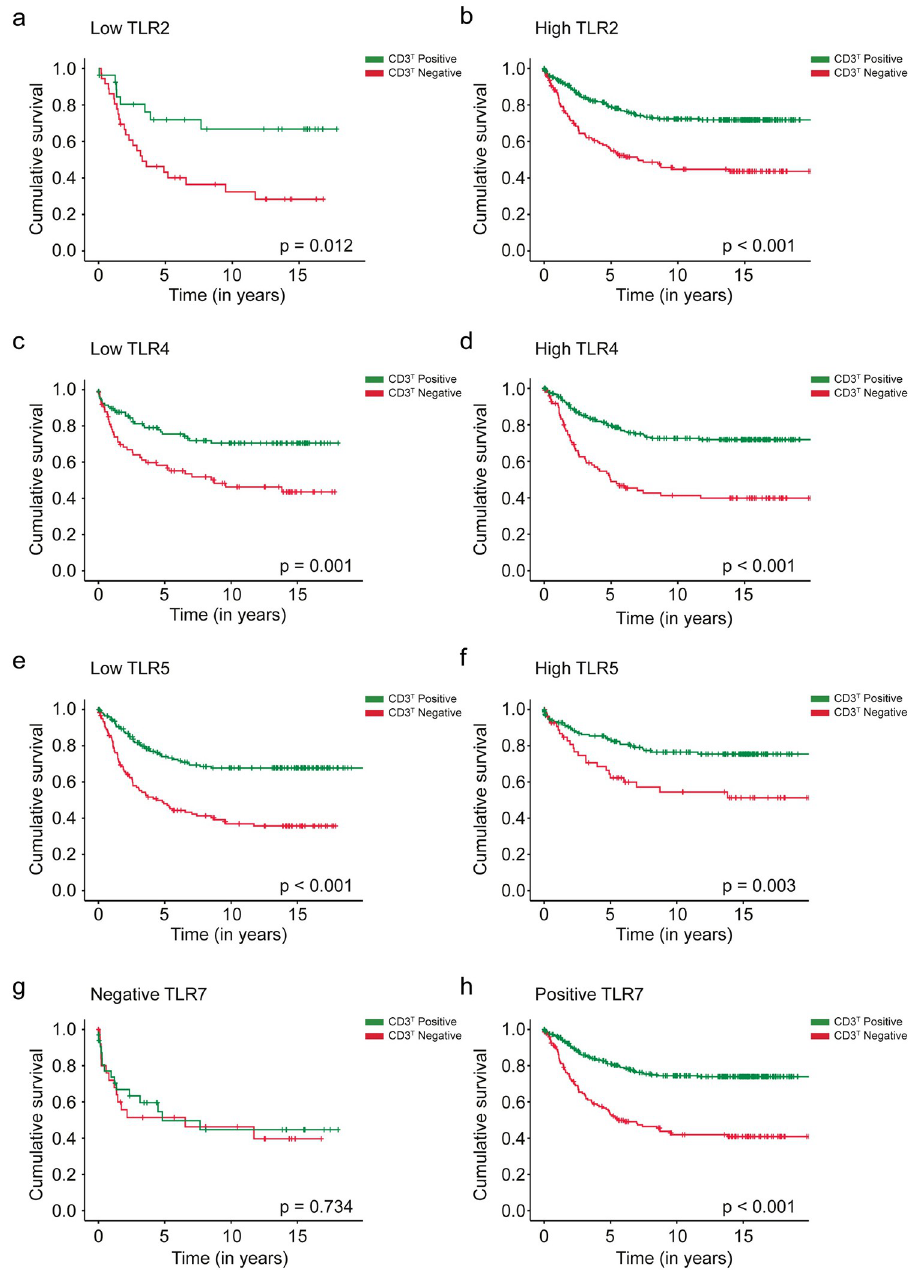
Fig 1. Disease-specific survival analysis of colorectal cancer patients using the Kaplan–Meier method. A negative versus positive intratumoral CD3 T expression among ( a ) low TLR2 expression patients, ( b ) high TLR2 expression patients, ( c ) low TLR4 expression patients, ( d ) high TLR4 expression patients, ( e ) low TLR5 expression patients, ( f ) high TLR5 expression patients, ( g ) TLR7-negative patients, and ( h ) TLR7-positive patients. The log-rank test was used. patients, those with a positive TLR7 immunoexpression exhibited a significantly better prog- nosis (HR 0.34; 95% CI 0.24–0.47; p < 0.001; Fig 1h). Patients with a positive CD8 T exhibited a better prognosis among subgroups with a high TLR2 expression (HR 0.38; 95% CI 0.27–0.52; p < 0.001; Fig 2b), a low TLR4 expression (HR